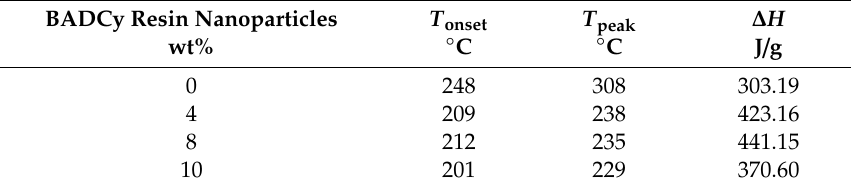
Table 1. Thermal characteristics of samples. BADCy: Bisphenol A